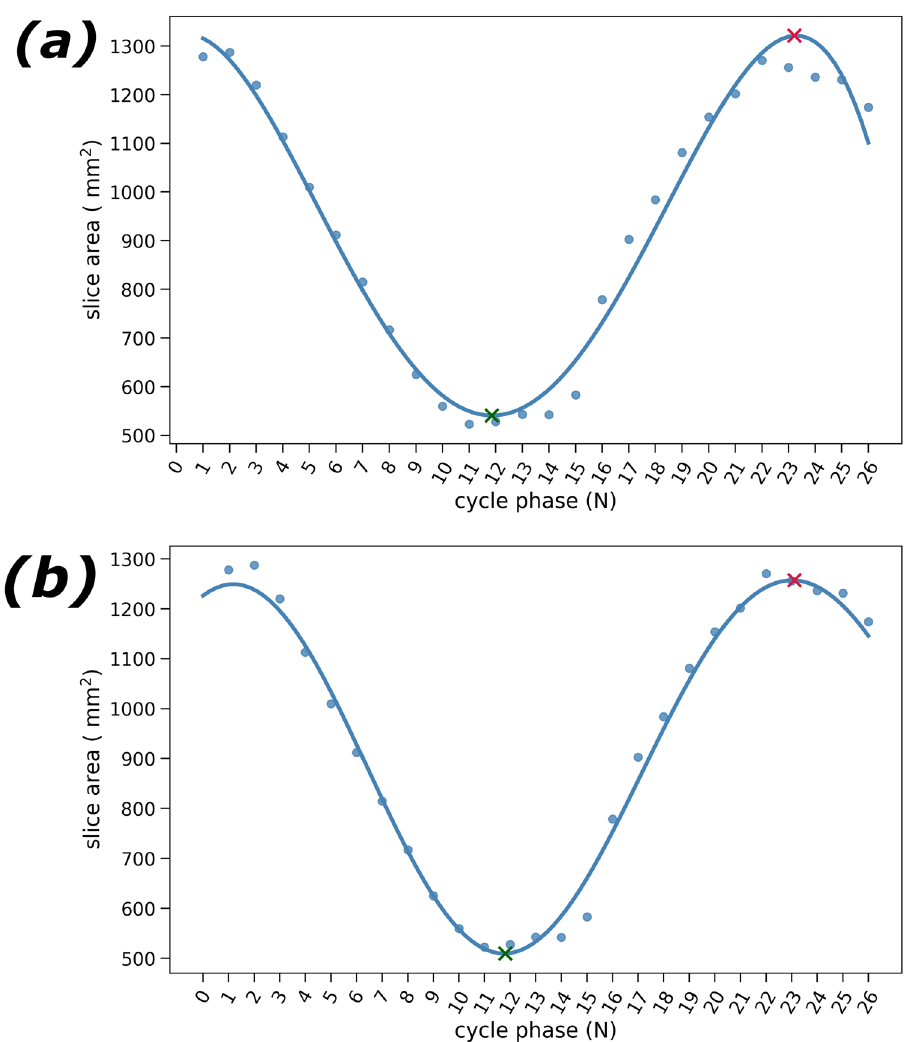
Figure 7. Cardiac cycle plot showing the evolution of the automatically selected slice area vs. the cycle phase. indicates the selected diastolic phase and the selected systolic phase. Their volumes are subsequently used to estimate the EF. Fourth-degree polynomial ( a ) and GP (kernel = Constant * RBF) ( b ) fitting methods. The polynomial fit considerably overestimates the end-diastolic volume and does not select an actual datapoint for the end-systolic volume, while the GP fits the datapoints more closely and affords a better estimation of the